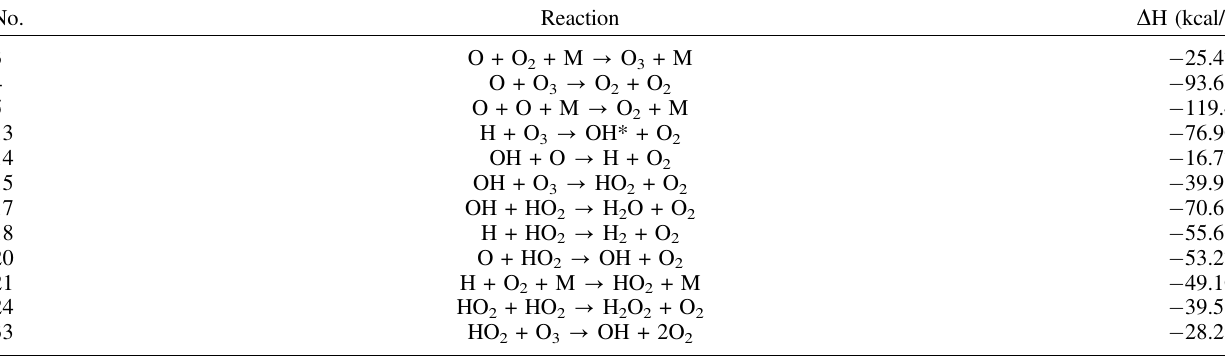
Table A.5. List of the reactions used for the chemical